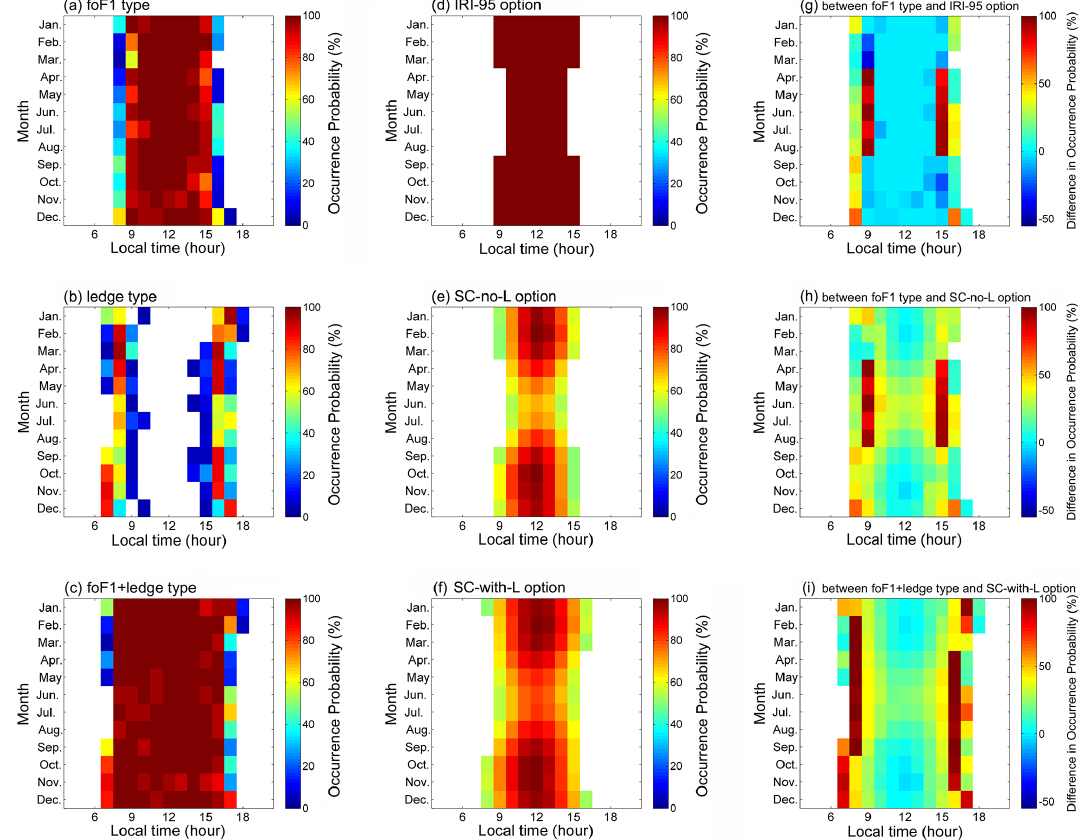
Figure 1. The F1-layer occurrence probabilities for the (a) fo F1, (b) ledge, and (c) fo F1 + ledge types of the Jicamarca digisonde, and for the (d) IRI-95, (e) SC-no-L, and (f) SC-with-L options of IRI-2012 during January–December 1996. The differences in occurrence probabilities (g) between fo F1 type and IRI-95 option, (h) between fo F1 type and SC-no-L option, and (i) between fo F1 + ledge type and SC-with-L option are